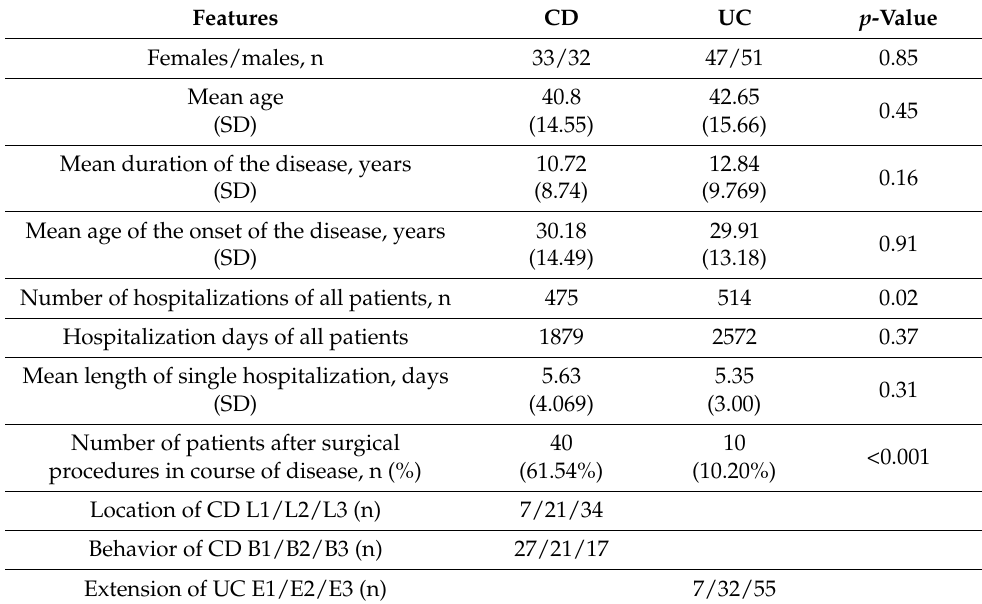
Table 2. Characteristics of the studied patients.